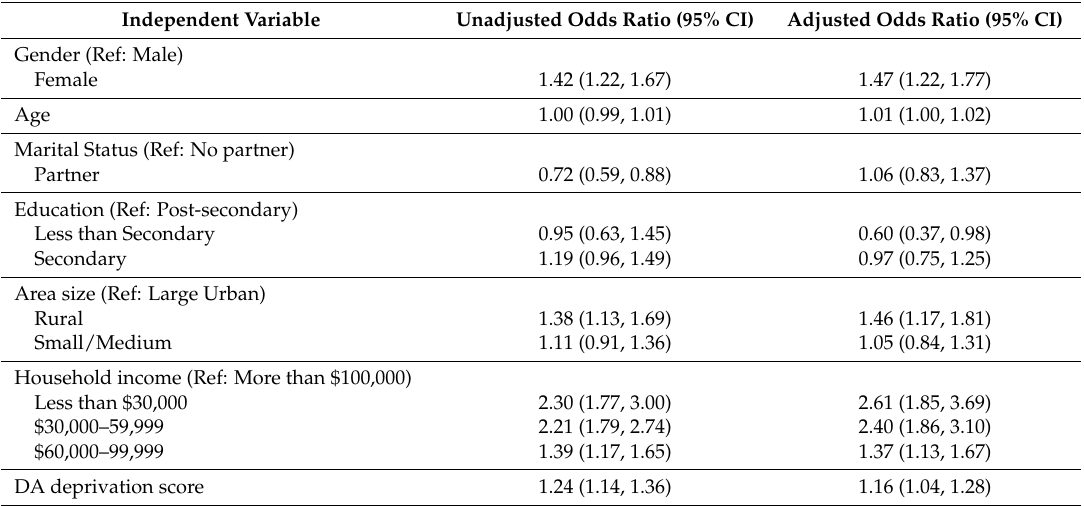
Table 4. Logistic regression predicting likelihood of reporting barriers to sports and recreation facilities.